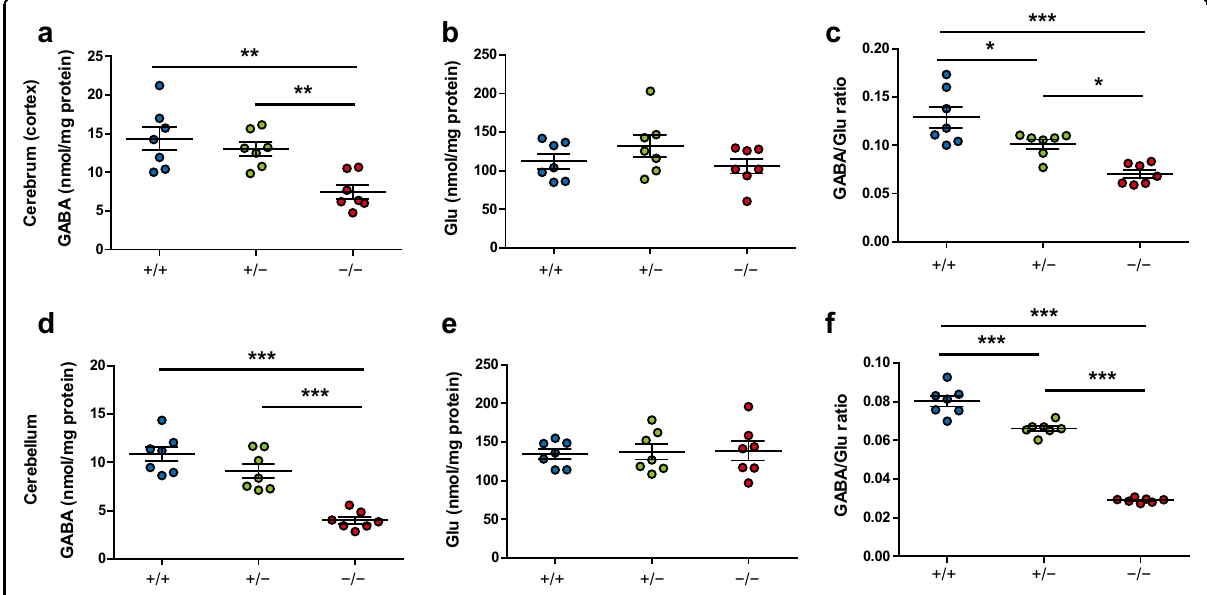
Fig. 2 GABA and glutamate concentrations in the brains of Gad1 knockout rats. Brain samples were collected from P20 to P24. a In the cerebral cortex, the GABA concentration in Gad1 − / − rats was reduced to 51.88% of that of Gad1 + / + ( F (2, 18) = 16.748, p < 0.001). b There were no differences in the glutamate (Glu) concentrations among the three genotypes in the cerebral cortex ( F (2, 18) = 1.4734, p = 0.2555). c The GABA/Glu ratio was reduced in both Gad1 + / − and Gad1 − / − rats in the cerebral cortex ( F (2, 18) = 10.578, p < 0.001). d GABA concentrations in the cerebellum ( F (2, 18) = 29.646, p < 0.001). e Glu concentrations in the cerebellum ( F (2, 18) = 0.0372, p = 0.9636). f GABA/Glu ratios in the cerebellum ( F (2, 18) = 218.79, p < 0.001). n = 7 in each genotype. The results are presented as the average ± SEM. The data were analyzed using one-way ANOVA and post hoc test adjusted by Holm ’ s method for multiple comparisons. * p < 0.05, ** p < 0.01, *** p <